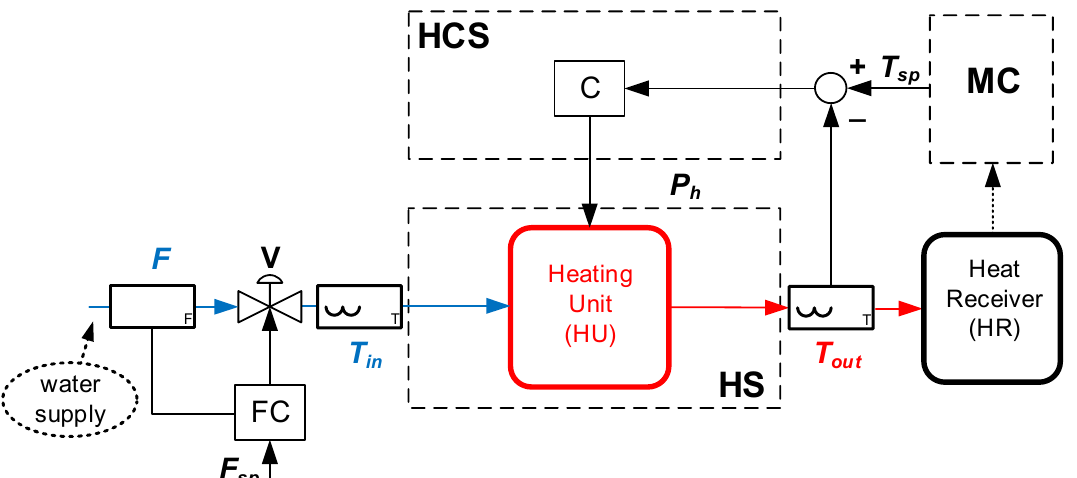
Figure 1. Schematic diagram of the traditional configuration of an HS. The heating system (HS) consists of a single heating unit (HU) with slow dynamics. The heating control system (HCS) consists of a single controller I operating in a single closed loop structure.